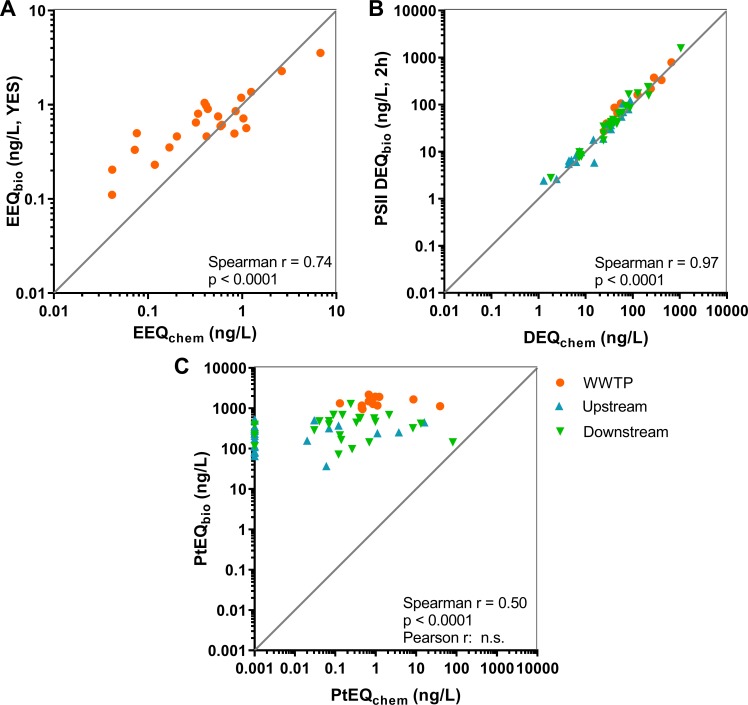
Correlation of bioanalytical equivalent (BEQbio) concentrations measured in (A) the Yeast Estrogen Screen (YES, 17β-estradiol equivalent concentrations, EEQbio, ng/L), (B) the combined algae assay (diuron equivalent concentrations, DEQbio, ng/L), and (C) the acetylcholinesterase (AChE) inhibition assay (parathion equivalent concentrations, PtEQbio, ng/L) to the values calculated by chemical analysis (EEQchem, DEQchem, PtEQchem
resp.) based on relative potencies of the measured estrogens, PSII inhibitors or AChE inhibitors in the bioassays. BEQs at 24 sites investigated in 2013/2014 in wastewater treatment plant effluent (all bioassays) as well as in the river up-and downstream of the WWTP discharge (combined algae assay and AChE inhibition assay). N = 24 (YES), n = 60 (algae, AChE). For the AChE assay “zero” values are displayed at 0.001 ng/L on the x-axis.